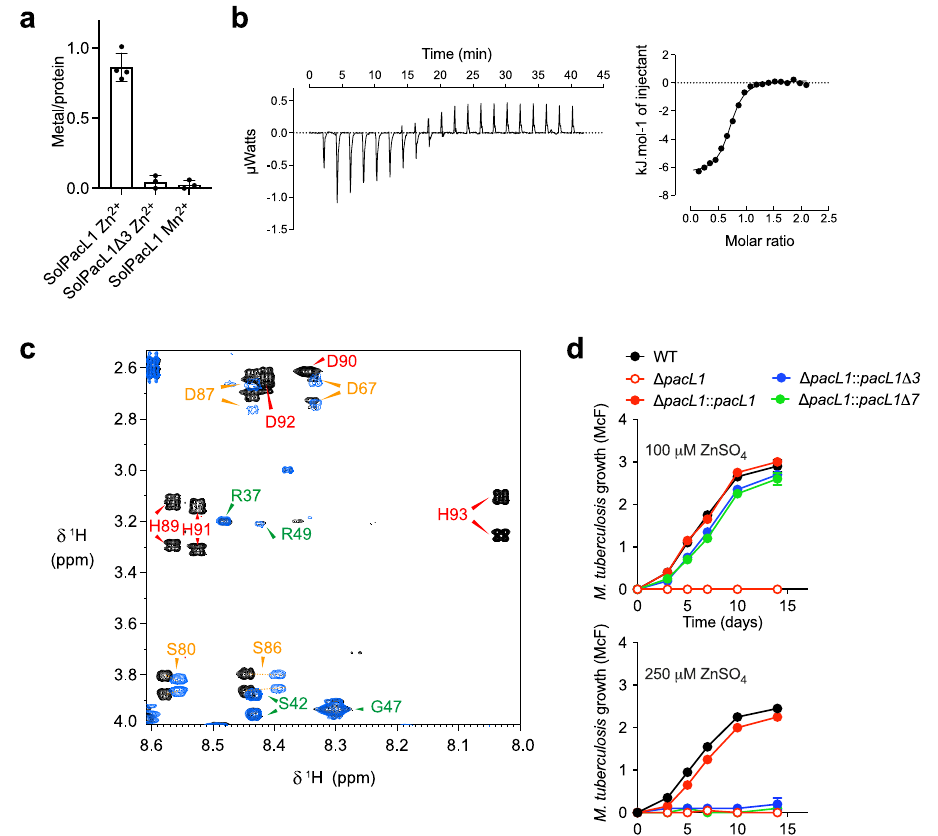
Fig. 4 | PacL1 binds zinc, but not manganese, in its C-terminal metal-binding motif. a Measurement of metal binding to solPacL1 and solPacL1 Δ 3 (50 µ M) by dialysis at equilibrium. Experiment was performed in 50mM MOPS pH 7, 200mM NaCl during21hat 4°C in the presence of 50 µ M ofthe indicated metal. Datashowmean±s.d.ofthreeindependentexperiments ( n =4perexperiment). b Isothermal titration calorimetry data. Thermograms and corresponding titra- tion curves obtained by successive injections of 2 µ L of 1.5mM Zn[CH 3 COO] 2 into the sample containing 150 µ M of puri fi ed solPacL1. Molar ratio is de fi ned as the number Zn per solPacL1. The data are representative of two independent experiments. c Superposition of 2D NMR TOCSY spectra (80ms mixing time) of solPacL1 (500 µ M in 20mM MES-d 13 pH 6.0, 100mM NaCl at 7°C) in the absence (black) and presence (blue) of 2 equivalents of zinc acetate. For clarity, the